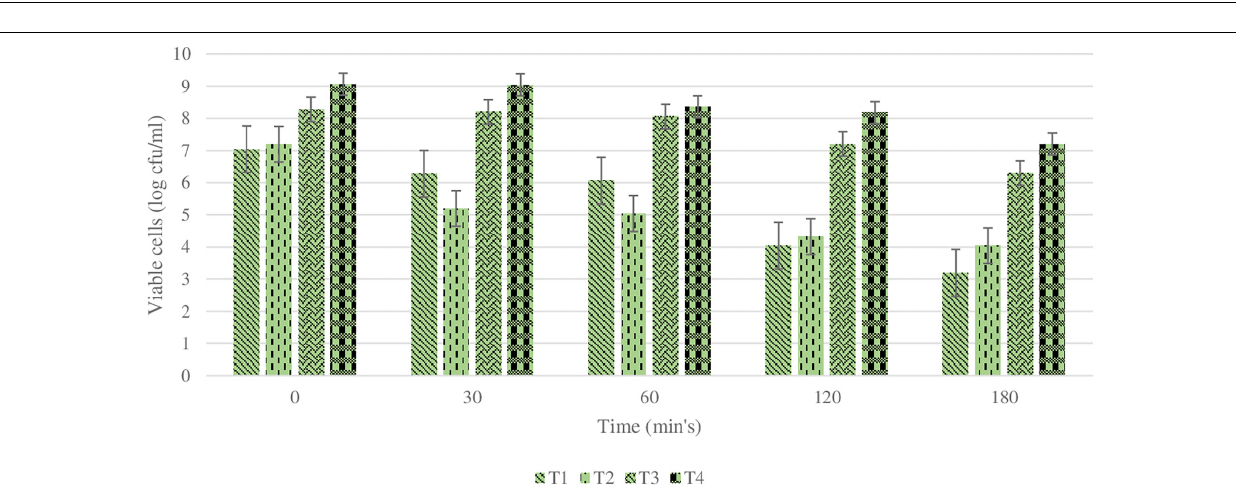
FIGURE 4 | Survival rate of plain and coated L. rhamnosus under simulated gastric fluids after 30, 60, and 120 min. Tl: plain L. rhamnosus, T2: coated cells with BSP/Glucomannan, T3: coated cells with BSP/alginate and T4: Coated cells with BSP/inulin.